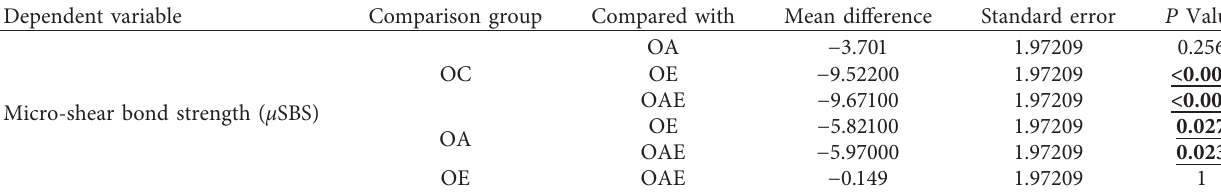
Table 6: Post hoc Tukey test for the opaque groups showing significant